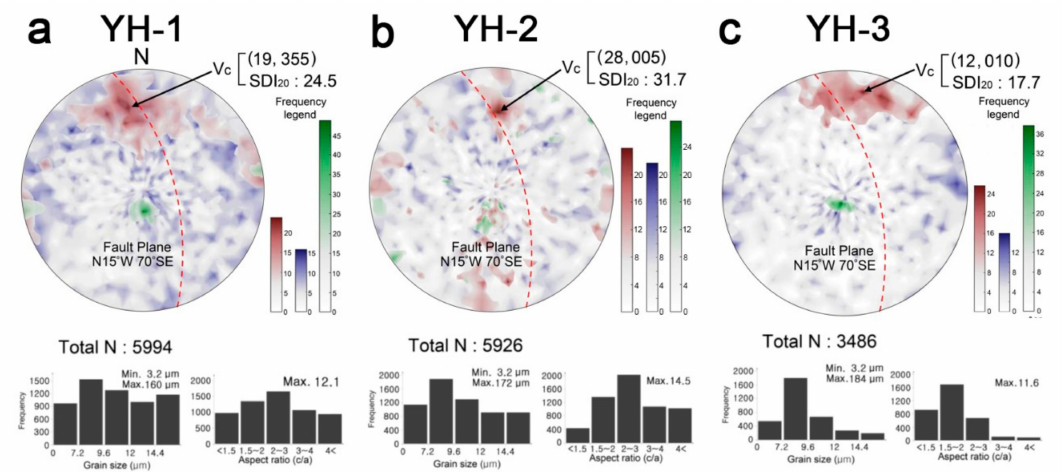
Figure 7. SPO measurements of YH samples (YH-1, ( a ); YH-2, ( b ); YH-3, ( c )) shown in lower-hemisphere stereoplots (lower-hemisphere, equal-area projection). Major axes are shown in red, intermediate axes in blue, and minor axes in green. For all axes, the dip azimuth, dip angle, and SDI20 values are given. Histograms show the distribution of grain sizes and aspect ratios. The number of grains analyzed, N, is given at the